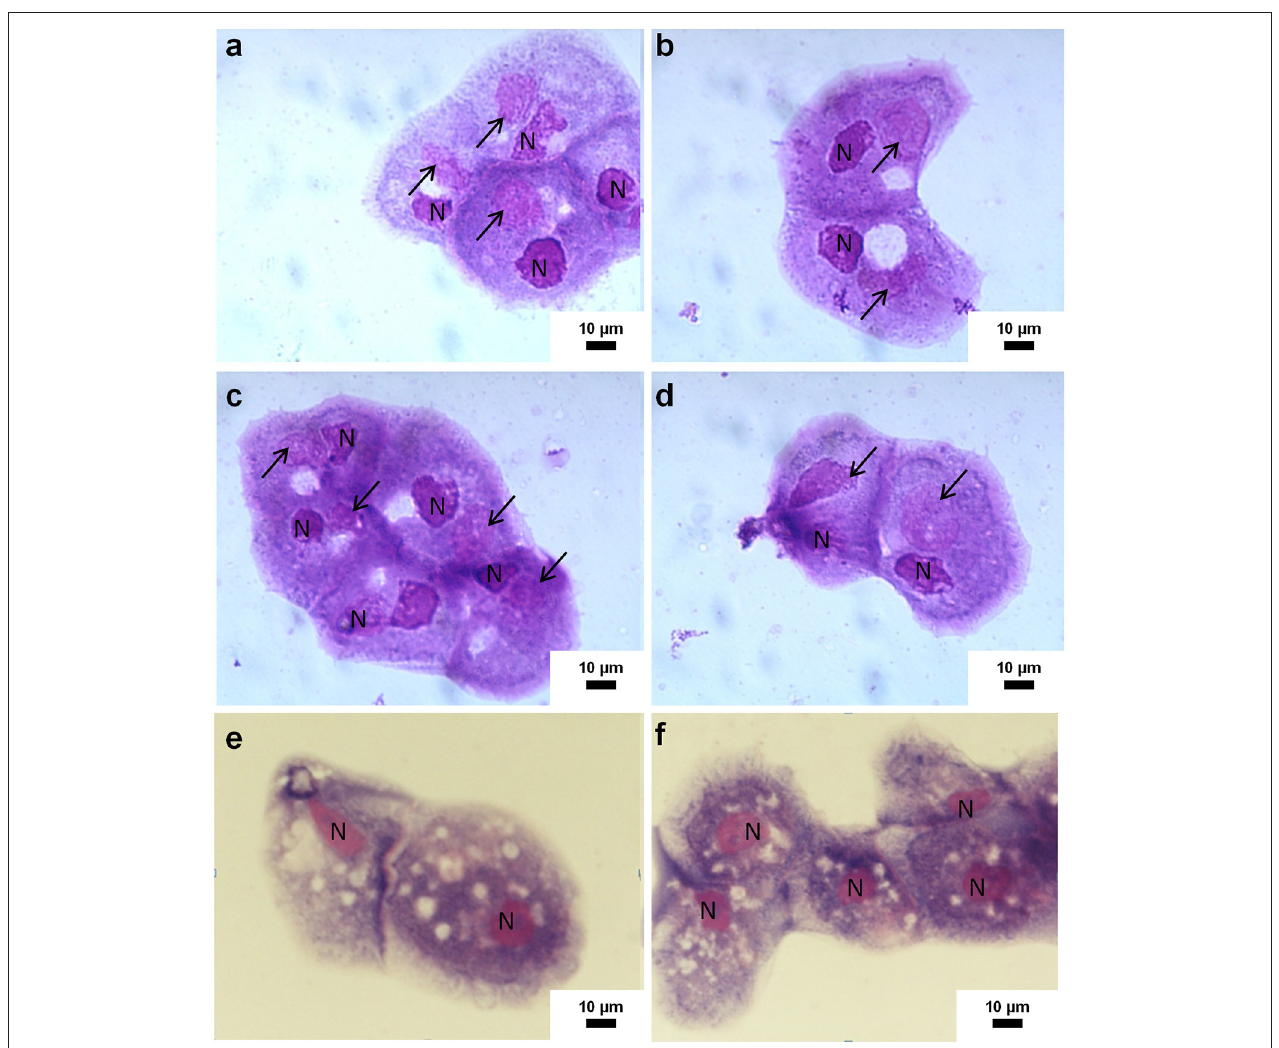
FIGURE 1 | Representative photomicrographs of co-culture of mice and rats samples on Acanthamoeba castellanii. Pictures (a–d) show positive samples by co-culture as indicated by the visible infected amoebas with Marseillevirus. These samples include NALT from aerosol inoculated mice and spleen from rats after IV inoculation with Marseillevirus. The arrows indicate viral factories and N indicate the nucleus of amoeba. Pictures (e,f) show negative samples by amoebal co-culture: the amoebas are not infected and do not contain viral